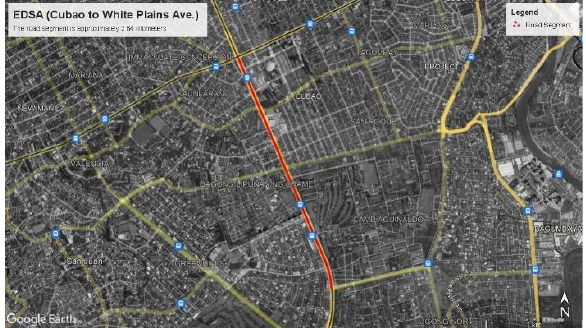
Figure 2. Figure 3.3. Map of EDSA Segment (Cubao to White Plains Ave. portion)